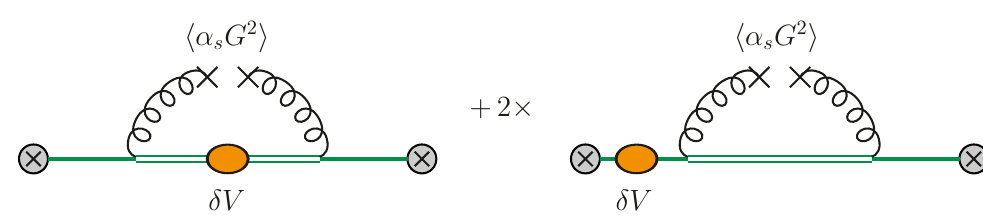
Figure 2 . Potential corrections to the dimension four condensate contribution to the Green func-